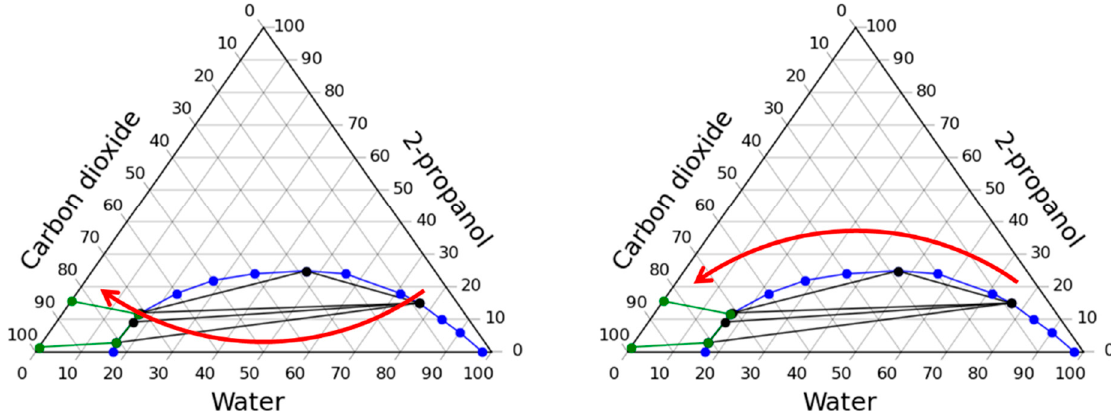
Figure 2. Two approaches to carrying out the process of the solvent exchange under pressure in a carbon dioxide medium: through the multiphase region ( left ) and through the homogeneous region ( right ).